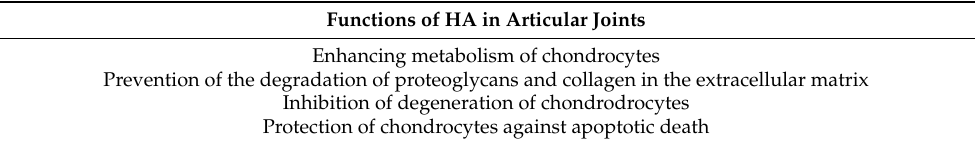
Table 1. Functions of HA in the synovium, the articular cartilage, and the extracellular matrix of the articular joint reviewed in reference